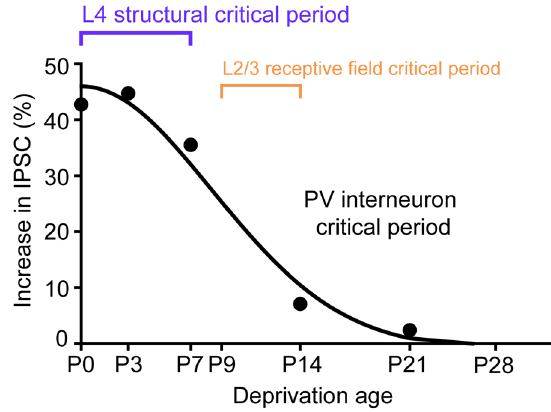
Figure 6. A critical period for experience-dependent plasticity in the inhibitory circuit. Curve depicts differences in mean IPSCs measured between control and deprived slices at different times of starting whisker deprivation. Sensory experience increases IPSCs in controls relative to deprived slices. The largest experience- dependent changes in IPSCs occurred at P0 and P7, decreasing sharply at P14 and P21 time points. Curve is a half-Gaussian fit with a half-width of approximately 10 days (R 2 = 0.95). Critical periods observed in layers 2/3 and 4 in the somatosensory cortex. The layer 2/3 receptive field critical period (yellow) was assembled from observations reported previously 40–42 . The layer 4 critical period (blue) illustrates the relationship between layer 4 barrel size and deprivation start date 39